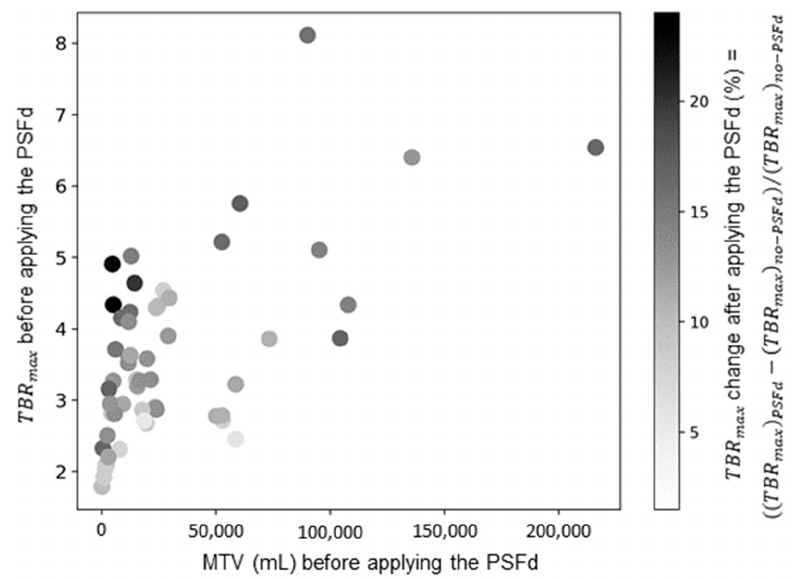
Figure 2. Distribution of TBR max changes after applying the PSFd. TBR max : maximum of tumor-to- background-ratio; MTV: metabolic tumor volume; PSFd: point spread function deconvolution.